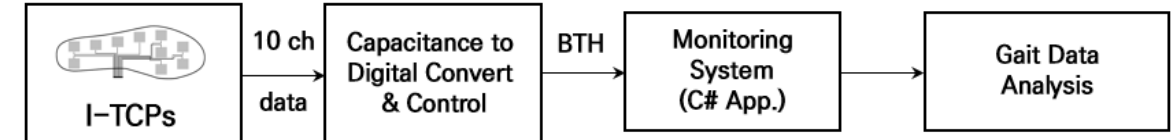
Figure 2. Structure of ( a ) textile capacitive sensor and ( b ) measurement board.